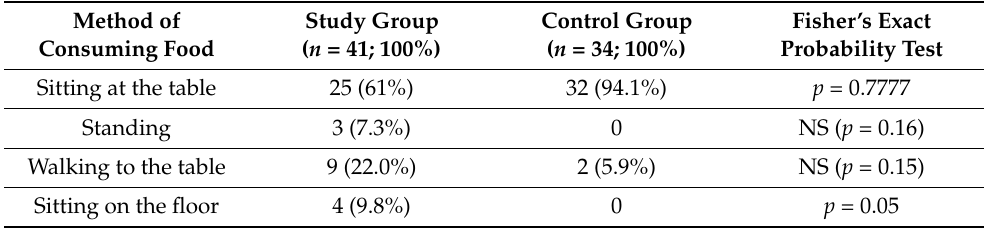
Table 6. Method of consuming food by children in the Study Group and the Control Group (ques- tion